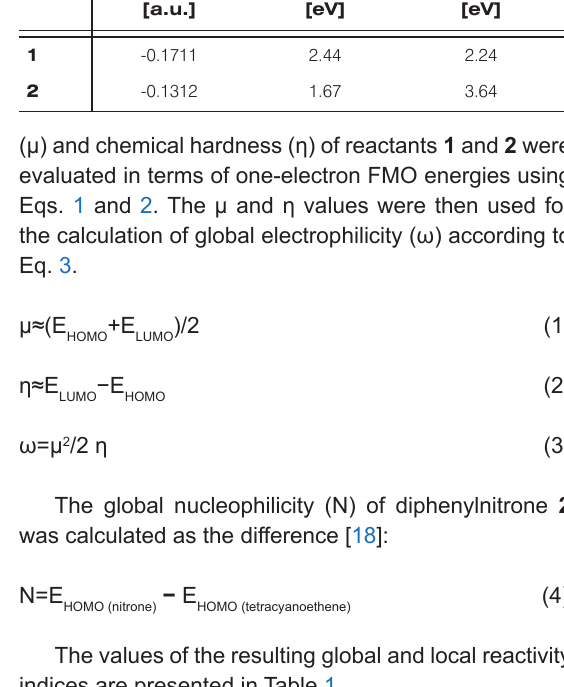
Table 1. Global reactivity indices for nitroalkene 1 and nitrone 2 . µ